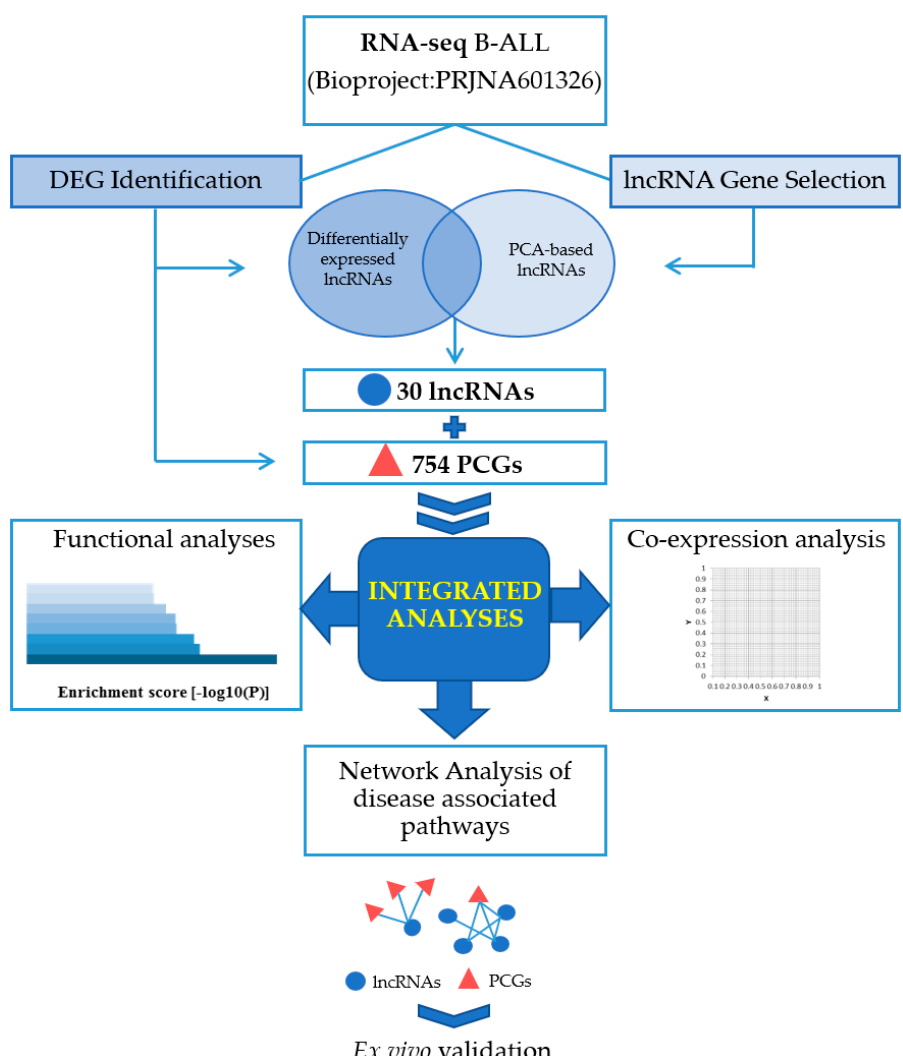
Figure 1. Methodological study workflow. Abbreviations: long non-coding RNAs (lncRNAs), differentially expressed genes (DEGs), protein-coding genes (PCGs), principal component analysis (PCA).